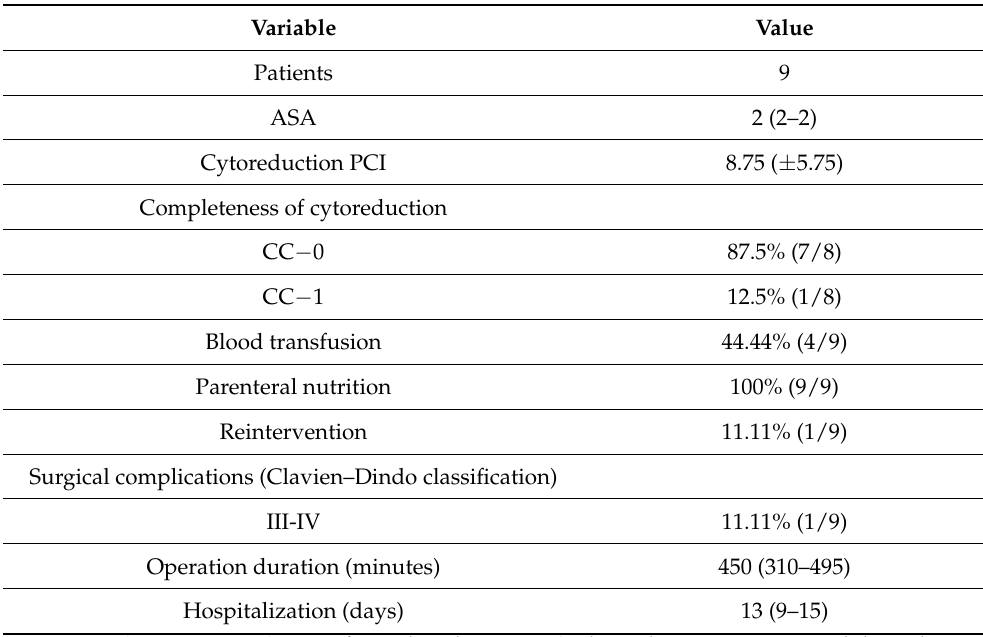
Table 3. Characteristics of the patients affected by PMP and treated with a third iterative CRS and HIPEC. Variable